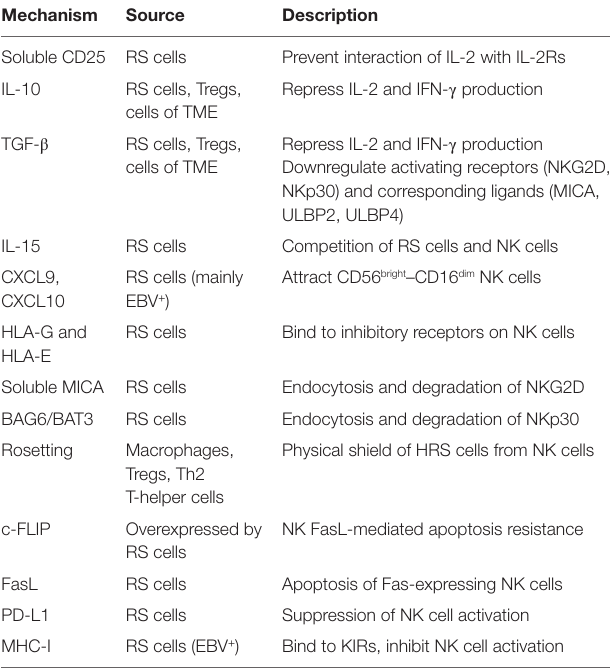
TABLe 1 | NK cell evasion mechanisms in